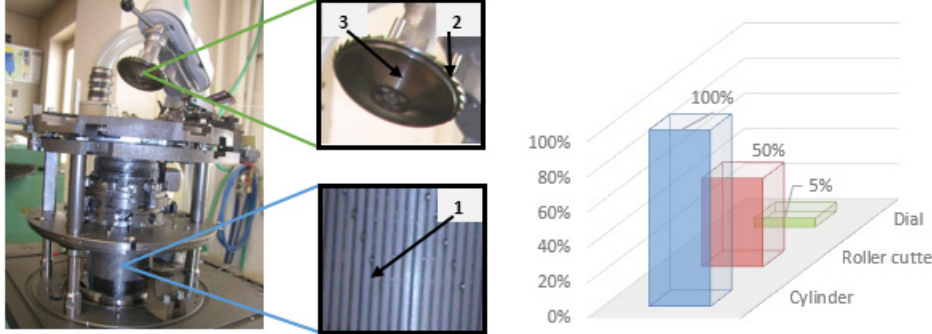
Figure 1. Cylinder 1, roller cutter 2, dial 3 and their percentage load during the knitting process.